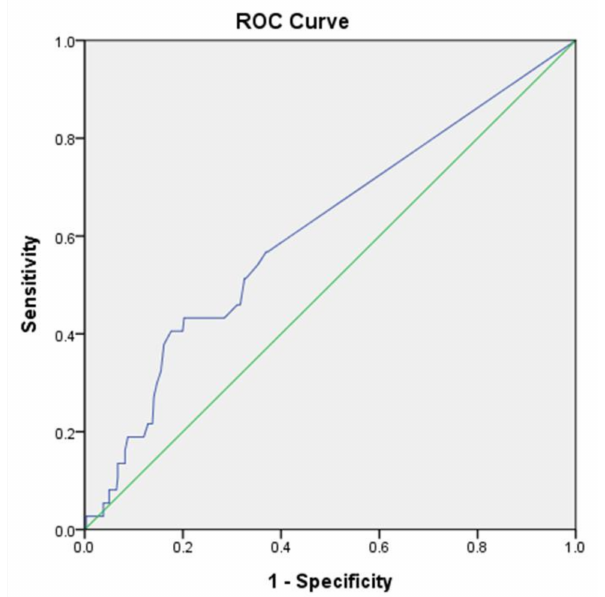
Figure 3. Receiver-operating characteristic curve analysis of fresh urine hs-TnI concentration vs. incident cardiovascular events in patients with DM. Urine hs-TnI concentration (pg / mL): Cut-o ff value, 1.55; sensitivity, 56.8%; specificity, 63.0%; AUC, 0.611; 95% CI, 0.511–0.711; p =